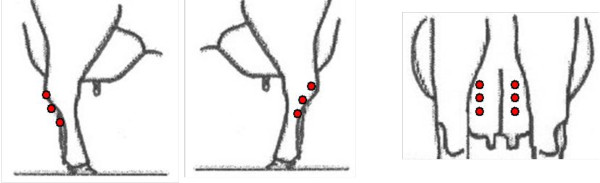
Laser simulation aimed at udder and hind legs. Graphic presentation of the position of the six single laser stimulations applied to the caudal part of the metatarsus on the hind legs and to the caudal part of the udder of dairy cows.